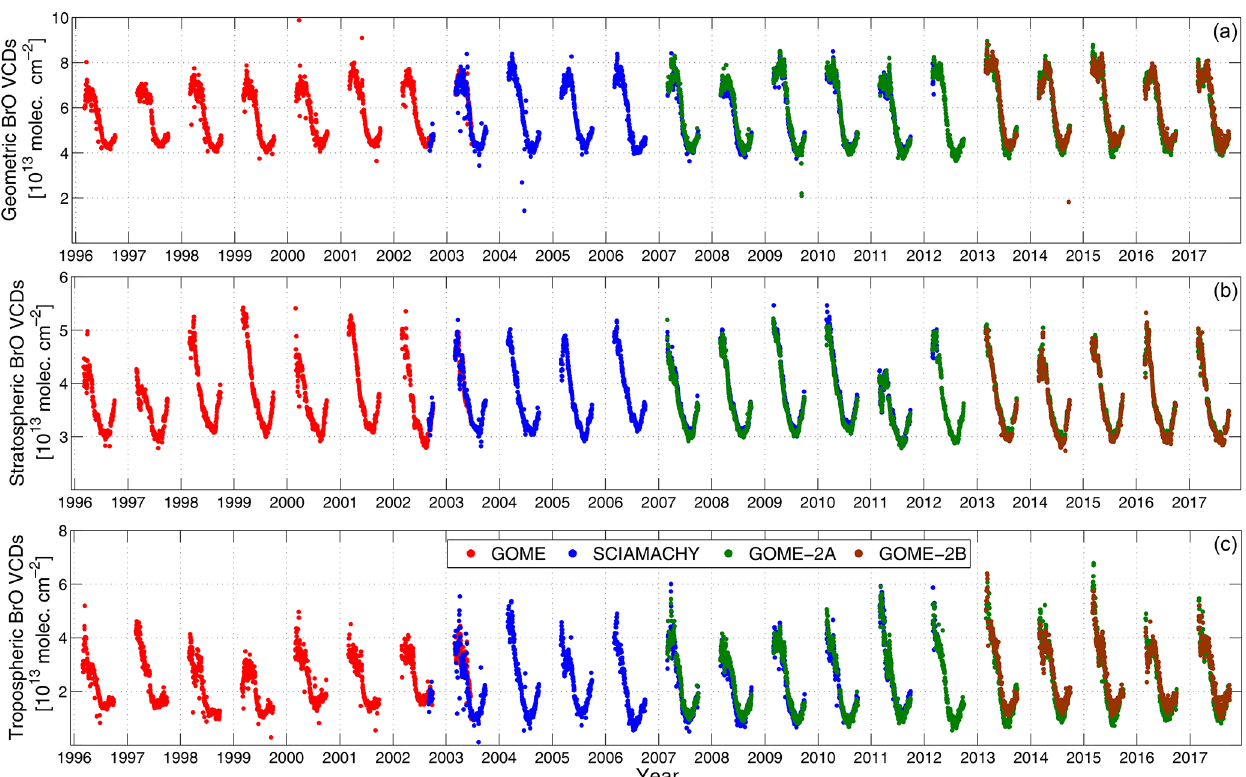
Figure 3. Long-term BrO time series over the Arctic region: (a) daily geometric BrO VCDs (10 13 moleccm − 2 ), (b) daily stratospheric BrO VCDs (10 13 moleccm − 2 ) and (c) daily tropospheric BrO VCDs (10 13 moleccm − 2 ). All figures show daily averages ≥ 70.0 ◦ N. GOME data are colored in red, SCIAMACHY in blue, GOME-2A in green and GOME-2B in